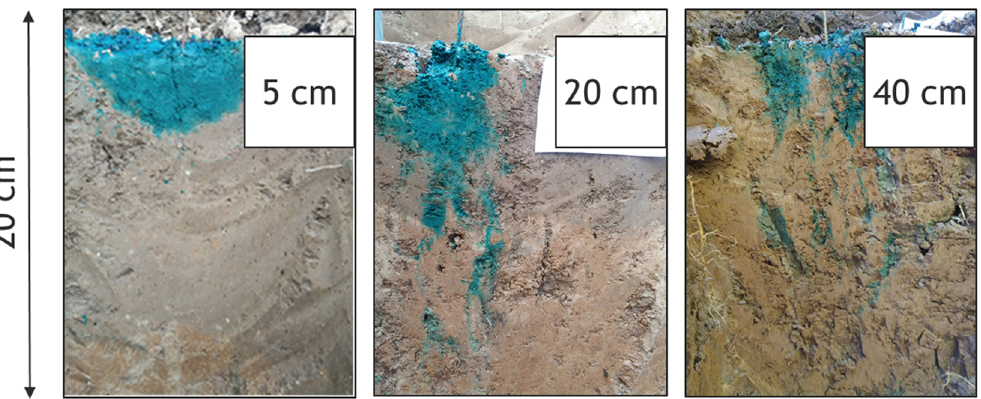
Figure 5: Migration of the marker substance along the soil pro fi le depending on con fi guration of the conducting